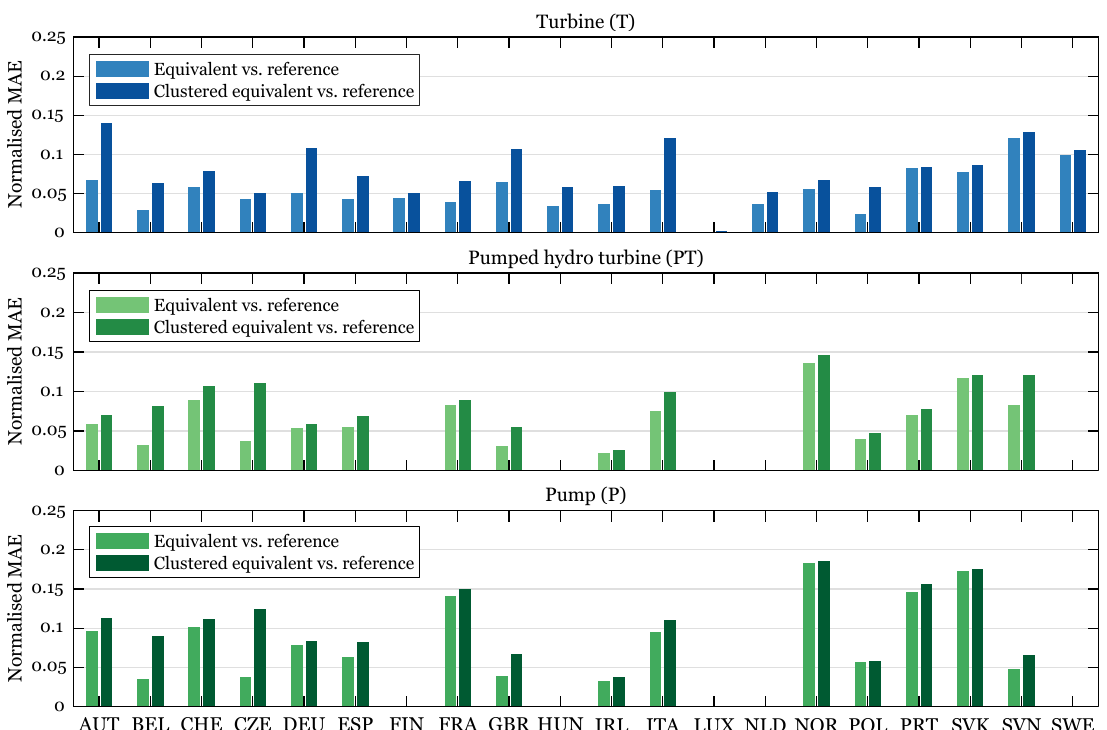
Figure 9. Normalised mean absolute error (MAE) of turbine, pumped hydro turbine, and pump schedules for equivalent and clustered equivalent vs. detailed reference model variant in all considered market